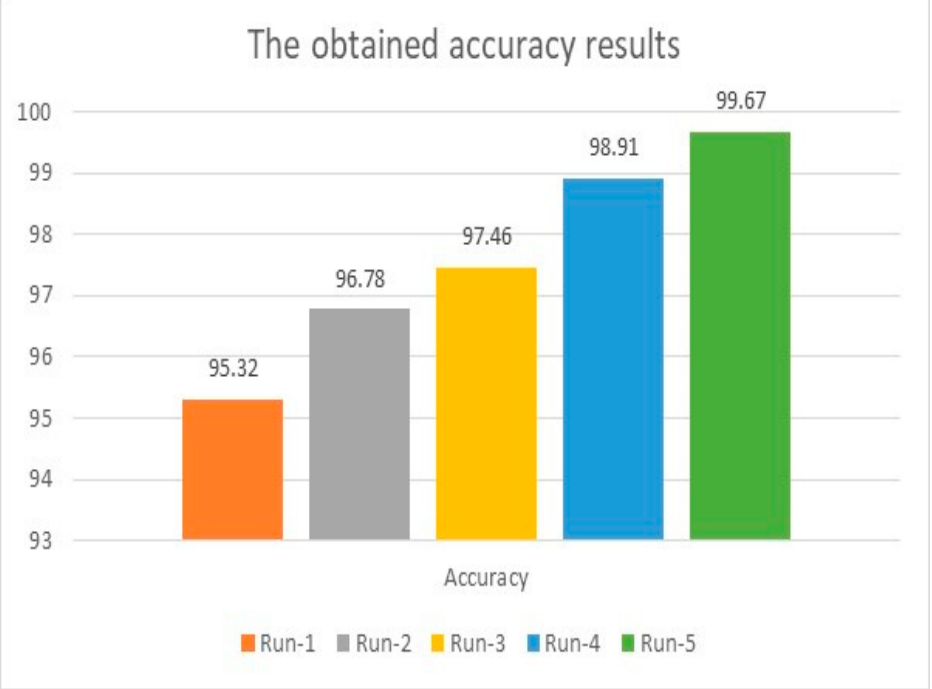
Figure 4. MAE and MSE evaluation using the integration of AlexNet and ResNet50V2. Table 3 lists the actual heartbeat, predicted heart rate, and error percentage between actual and estimated heart rates. This table indicates that the maximum obtained error among all volunteers is 3.125%. In addition, this table shows that the proposed technique correctly predicted 70% of the sample size. Moreover, the obtained MAE was 0.3, and MSE was 1.8. Both values are small, implying that the presented model estimated heart rate with an acceptable level of correctness. To obtain the actual heartbeat rates for all